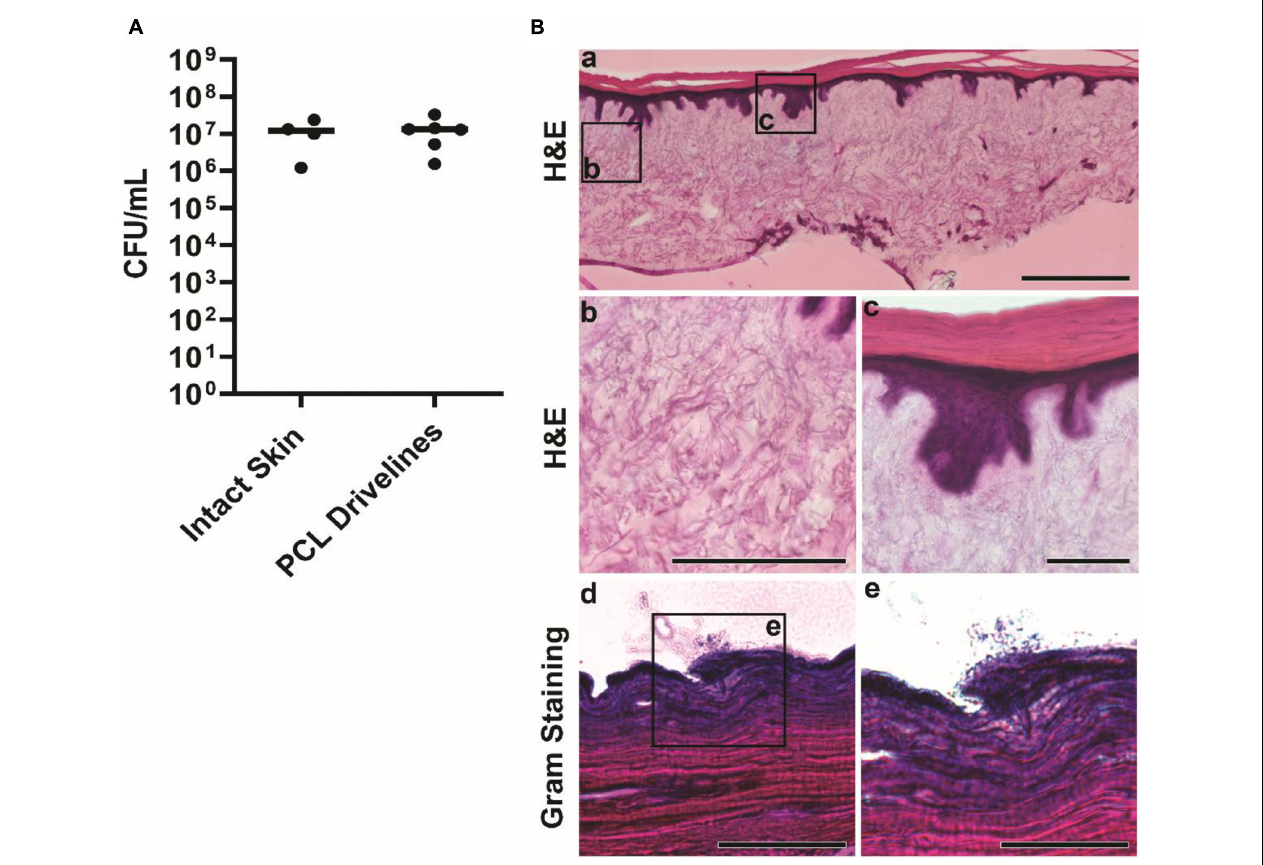
FIGURE 3 | Staphylococcus aureus infection of intact HSEs. (A) Number of viable S. aureus colony forming units (CFU) recovered from intact skin HSEs (no driveline) or HSEs implanted with smooth PCL drivelines at 24 h post inoculation. Bacterial numbers are presented as CFU/mL with group means shown as horizontal lines. Dot plots show data from a minimum of 4 experimental repeats using HSEs derived from 3 skin donors. (B) Histological analysis of infected intact HSEs showing an overview of cross sections of the entire skin construct by H&E staining. Visible features include rete ridges between the epidermis and dermis (panel a, scale bar: 500 µ m), connective dermal tissue (panel b, scale bar: 200 µ m) and the epidermis and stratum corneum (panel c, scale bar: 100 µ m). Gram staining of tissue cross-sections revealed S. aureus localizing exclusively on the uppermost layer of the epidermis in loose association with the skin tissue (panels d and e, scale bars: 100 µ m and 50 µ m,